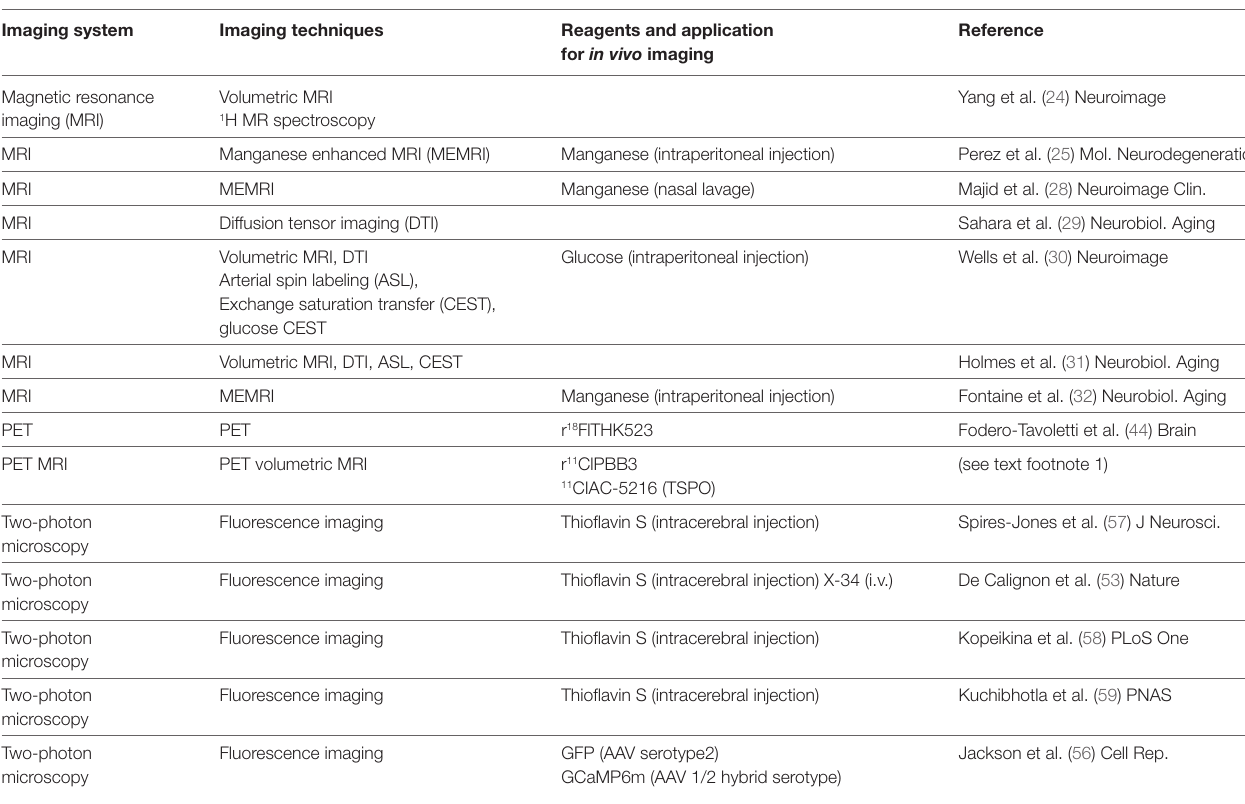
TAbLe 1 | Reference list for in vivo imaging in living rTg4510